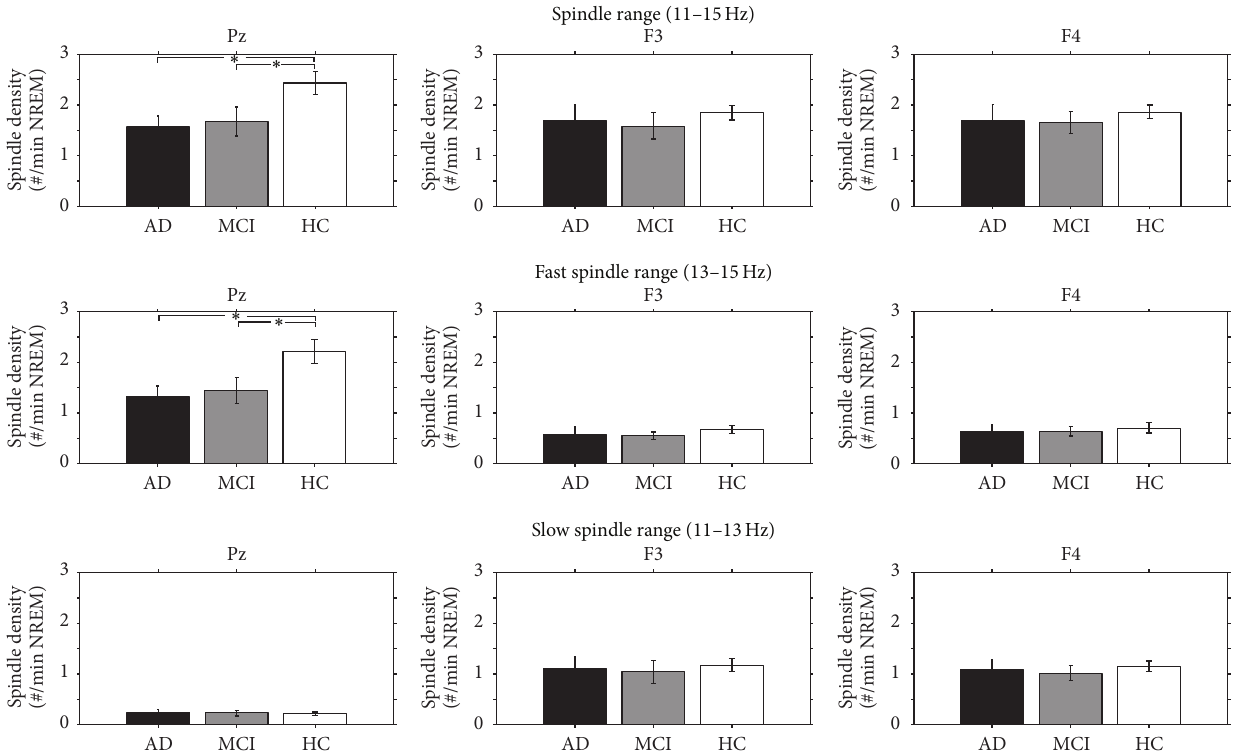
Figure 2: Whole range (11–15Hz), fast (13–15Hz), and slow (11–13Hz) spindle density of AD patients (black bars), amnesic MCI patients (gray bars), and HC (white bars) in the cortical derivations where the maximum mean density values were observed for fast (Pz) and slow (F3 and F4) spindles. Error bars represent the standard errors. Asterisks indicate between-groups statistically significant differences ( 𝑝 ≤ 0.05 ) after post hoc unpaired 𝑡 -tests.